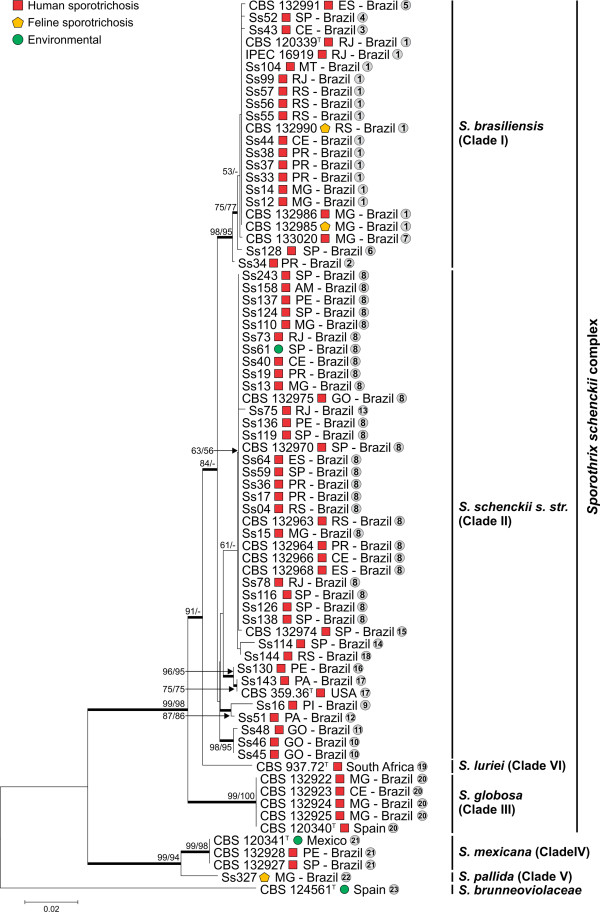
Phylogenetic relationships of calmodulin-encoding gene and ITS sequences among clinical and environmental Sporothrix species. The phylogenetic tree were estimated in MEGA5 using the Tamura 3-parameter model. The numbers close to the branches represent indices of support (NJ/ML) based on 1,000 bootstrap replications. The branches with bootstrap support higher than 70% are indicated in bold. Haplotypes numbers were assigned to each isolate and are indicated inside the circles.